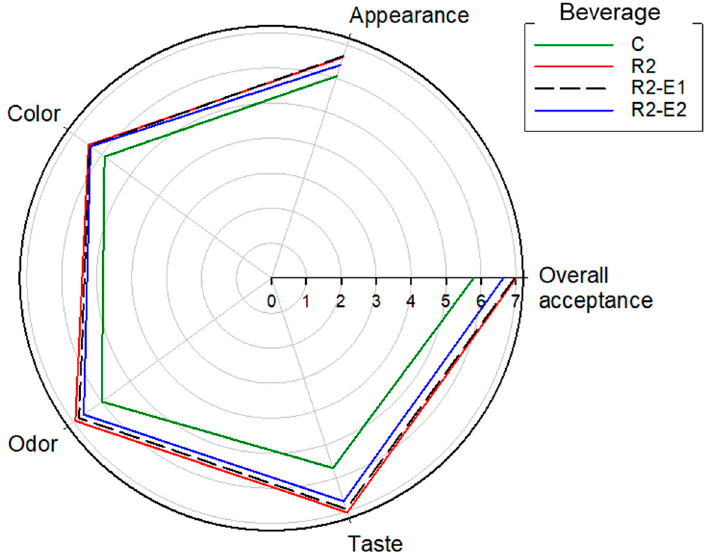
Figure 5. Sensory evaluation scores of the beverages: C, sterilized whole pineapple juice (control, C); R2, fermented whole pineapple juice Recipe 2 (R2); R2-E1, product R2 supplemented with 2% v / v ethanol; R2-E2, product R2 supplemented with 4% v / v ethanol. Data are mean values ± standard deviation (n = 30). Each score was generated by 30 individuals using a 9-point hedonic scale ranging from 1 (dislike very much) to 9 (like very much).